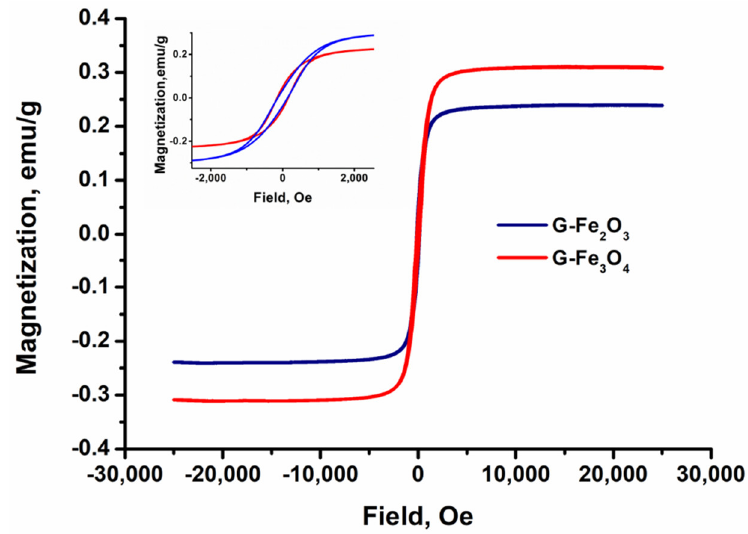
Figure 8. Magnetic behaviour of G – Fe 2 O 3 and G – Fe 3 O 4 materials at room temperature.